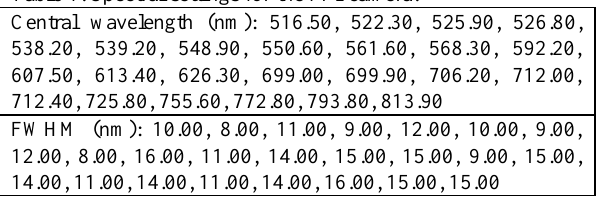
Table 1. Spectral settings for the FPI